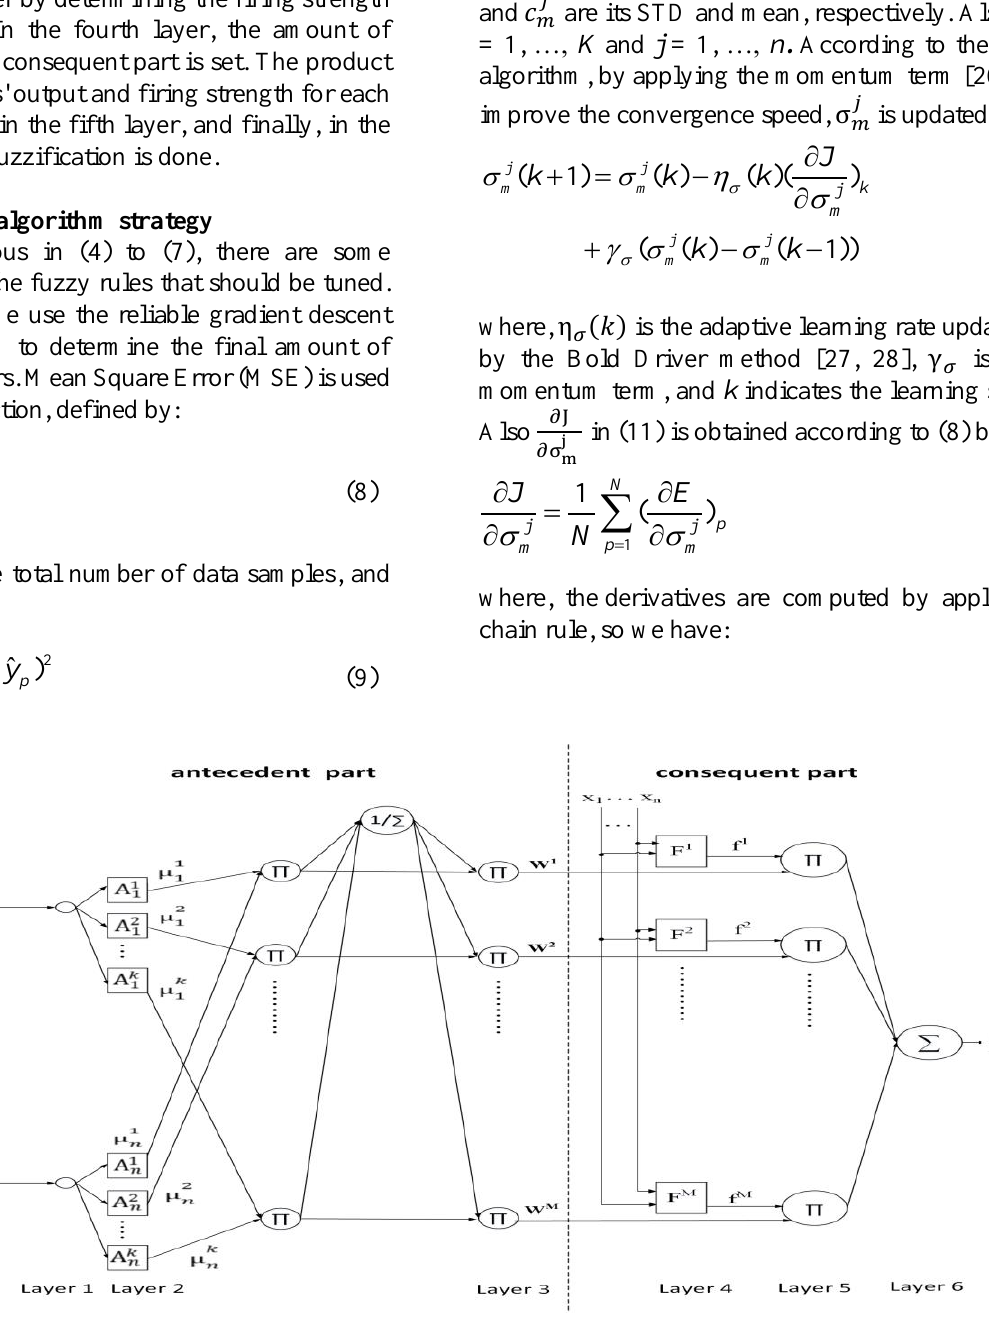
Figure 2. Structure of